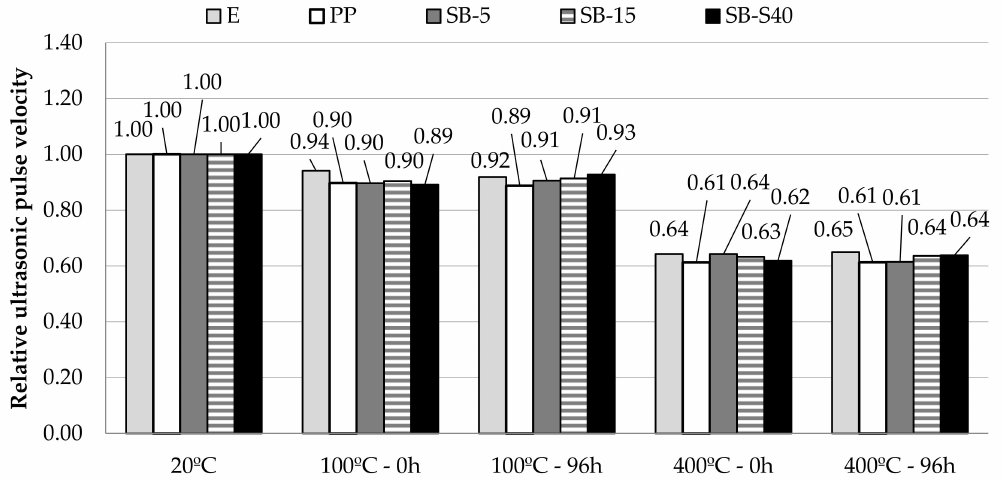
Figure 8. Residual ultrasonic pulse velocity of specimens compared with the ultrasonic pulse velocity of the same mixture at room